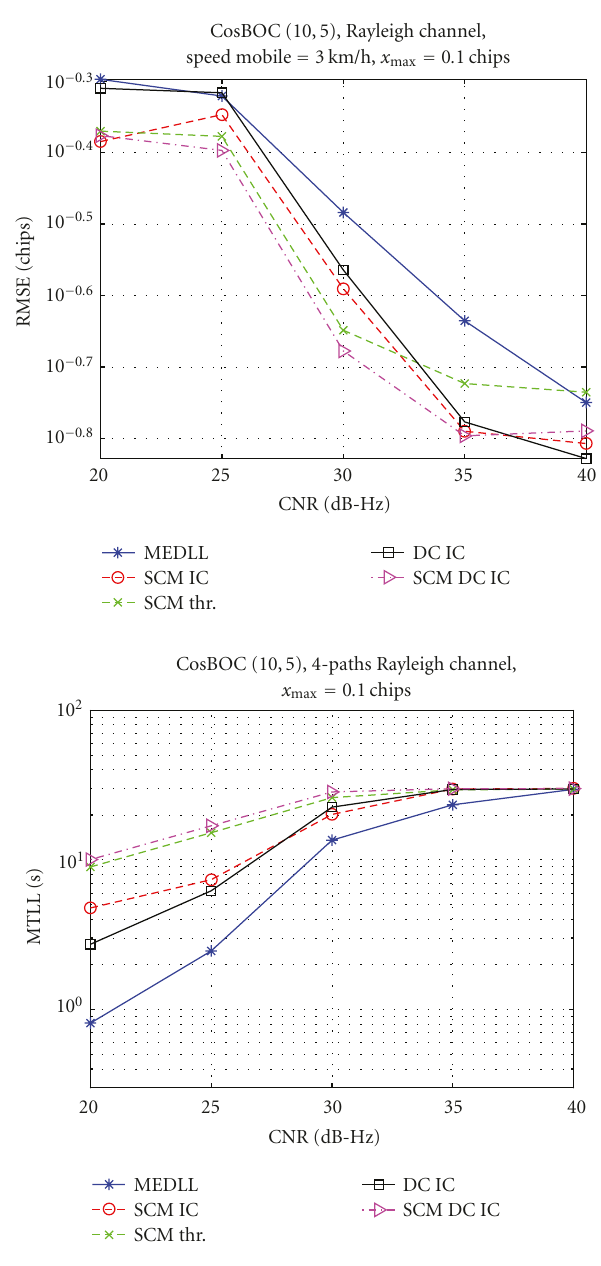
Figure 24: Comparison of feedforward delays estimation algo- rithms employing the MEDLL and IC methods and of the SCM with threshold approach, as a function of CNR; CosBOC(10,5) modula- tion, 4-paths indoor Rayleigh channel, v = 3 km/h, closely-spaced paths x max = 0 . 1 chips.